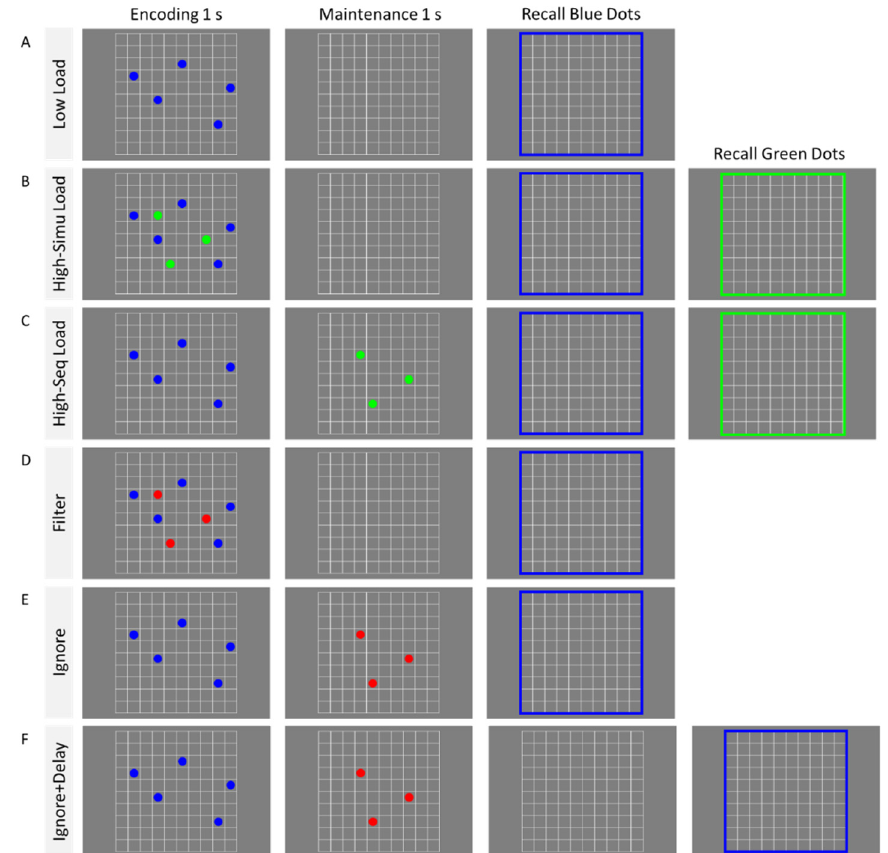
Figure 1. Example of conditions in Experiment 1. In the Low-Load condition ( A ) participants encoded blue dots and later reproduced them by clicking on the corresponding grid cells. In High-Simultaneous Load ( B ) and High-Sequential Load ( C ) conditions, participants encoded both blue and green dots. In the Filter condition ( D ), participants encoded the blue dots while ignoring the red dots presented at encoding. In the Ignore condition ( E ), participants encoded first the blue dots and ignored the red dots presented during the maintenance phase. In the Ignore+Delay condition ( F ) the recall test was presented after an additional delay of 1000 ms.